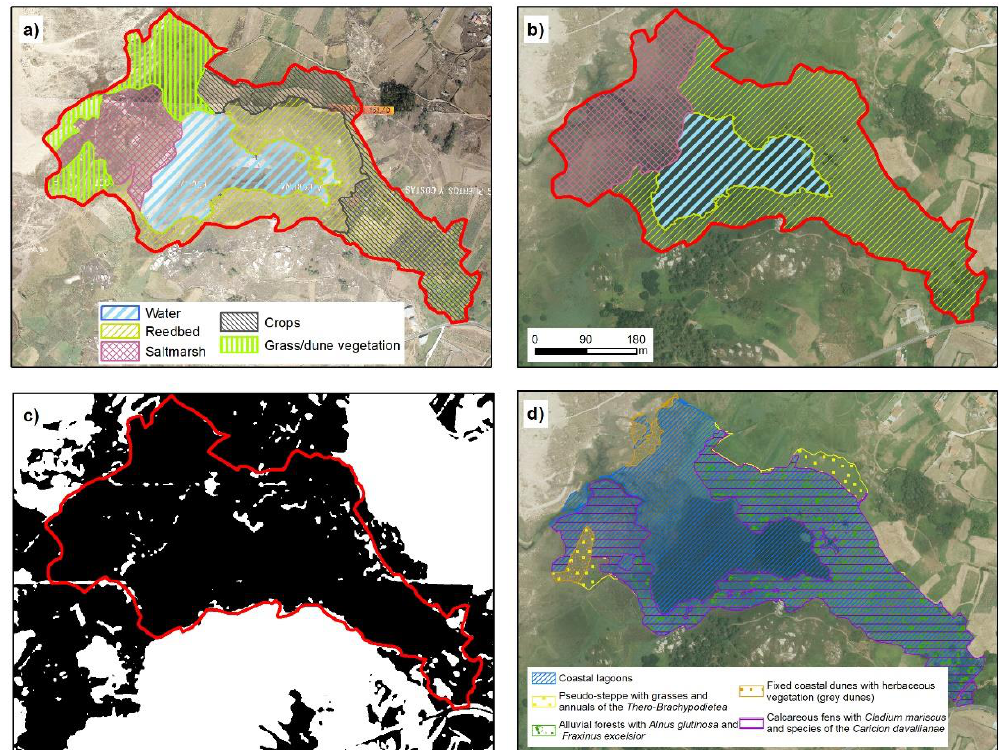
Figure 4. Coastal lagoon of Vixán. ( a , b ) represent the temporal evolution of environmental units in 1989 and 2017, respectively. On the lagoon back appear two categories, reedbed and crops, because this part is occupied for reedbeds and the local inhabitants using the zone for their crops. ( c ) shows TRI classification, in black, values below mean and in white the values above mean. ( d ) O ffi cial cartography representing the distribution of habitats from Annex I of Habitats Directive. The red line in all cases represent the extent marked for the lagoon by our analysis (IGN [20]; Xunta de Galicia ©